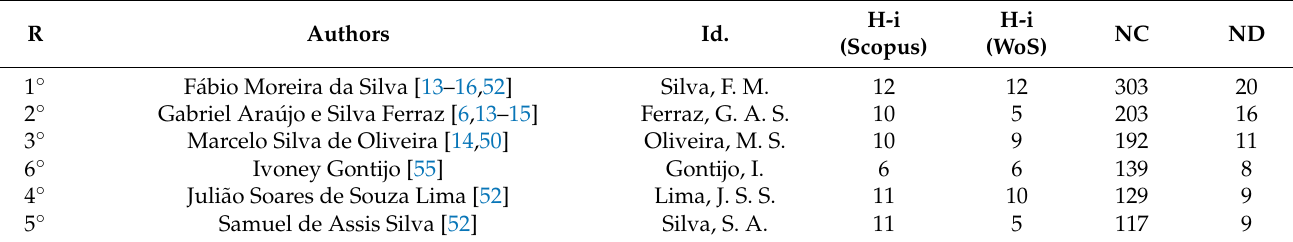
Table 3. Top six relevant authors of publications on precision coffee growing from 2000 to 2021/1st